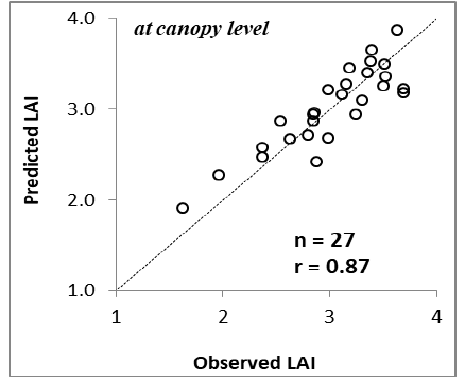
Figure-9 Predicted LAI vs Observed LAI